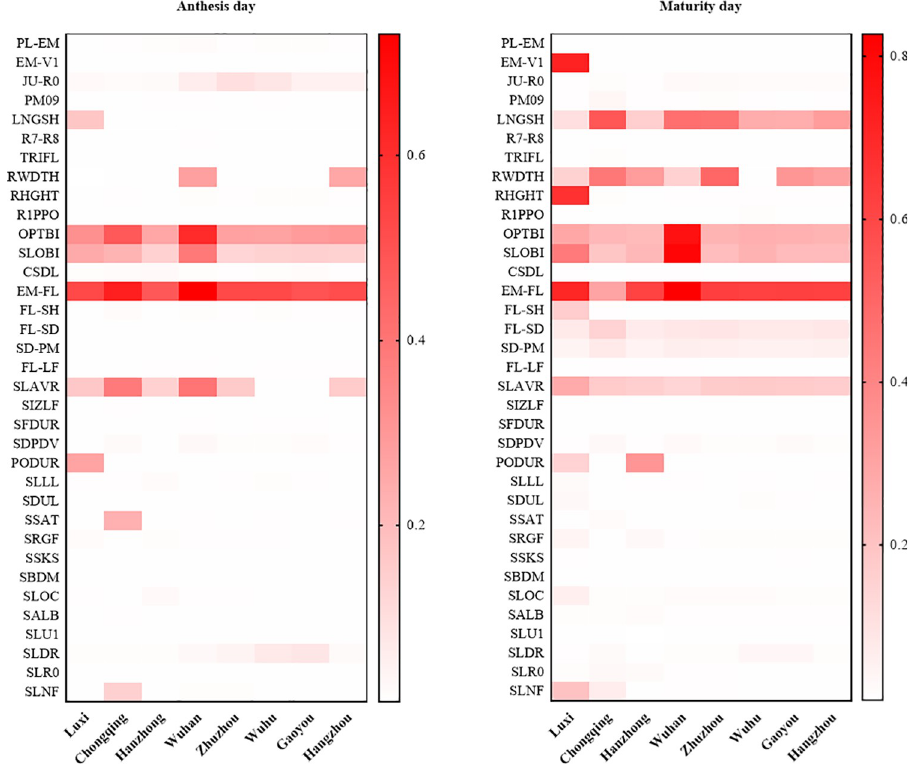
Fig 3. Spatial sensitivity indices of phenology to model input parameters. Note . I: ecotype parameters; II: genotype parameters; III: soil parameters.